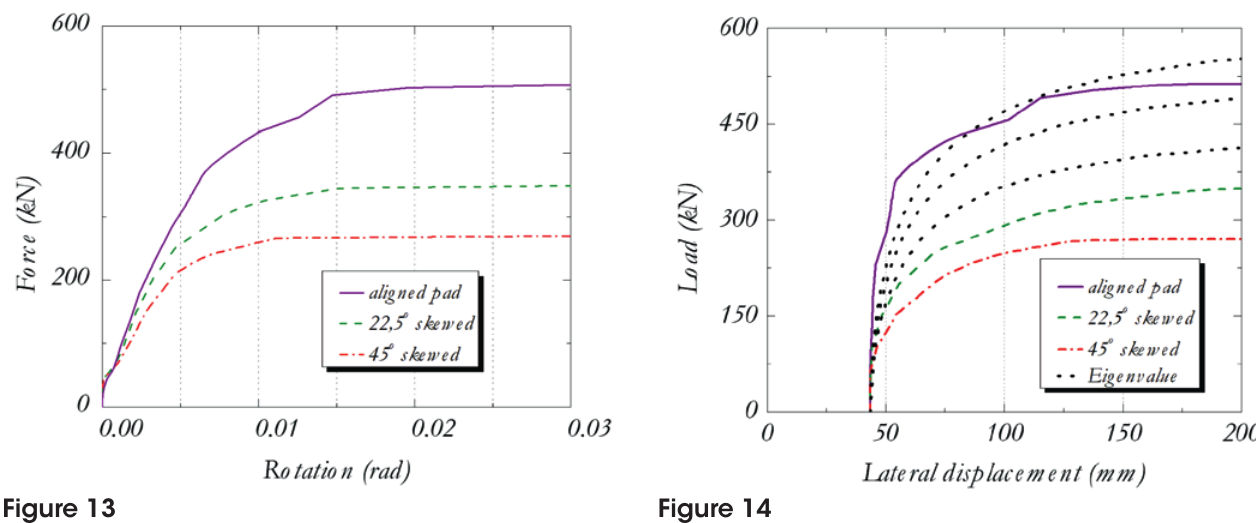
Load-rotation response for aligned and skewed pads